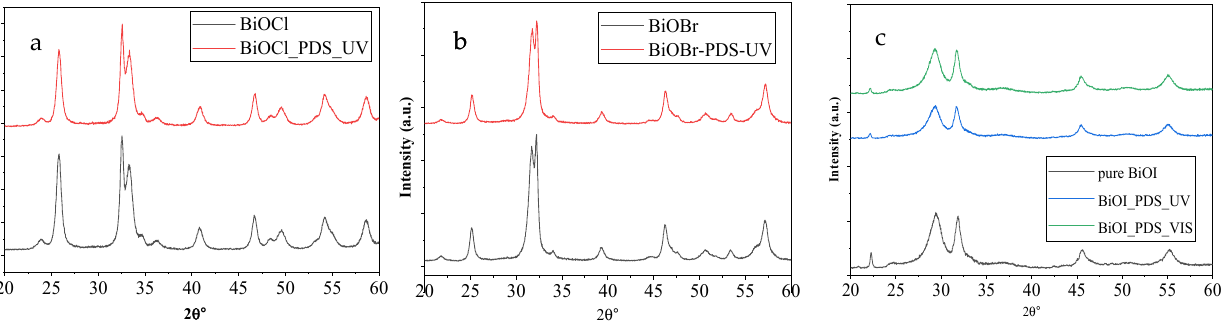
Figure 5. The Effect of PDS on the XRD diffractogram of BiOX (( a ): BiOCl; ( b ): BiOBr; ( c ): BiOI) photocatalysts under UV and Vis radiation in aerated suspensions.